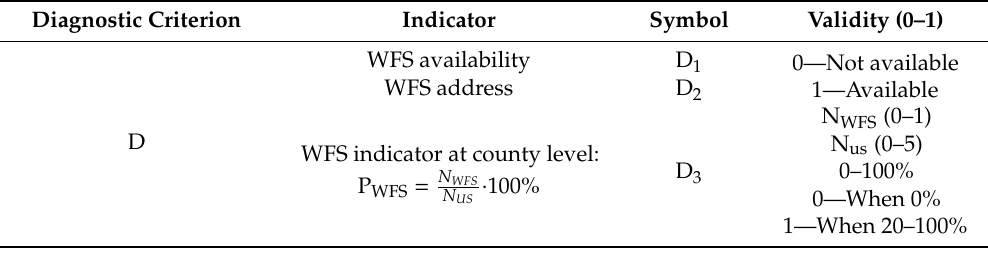
Table 5. WFS Network Service.